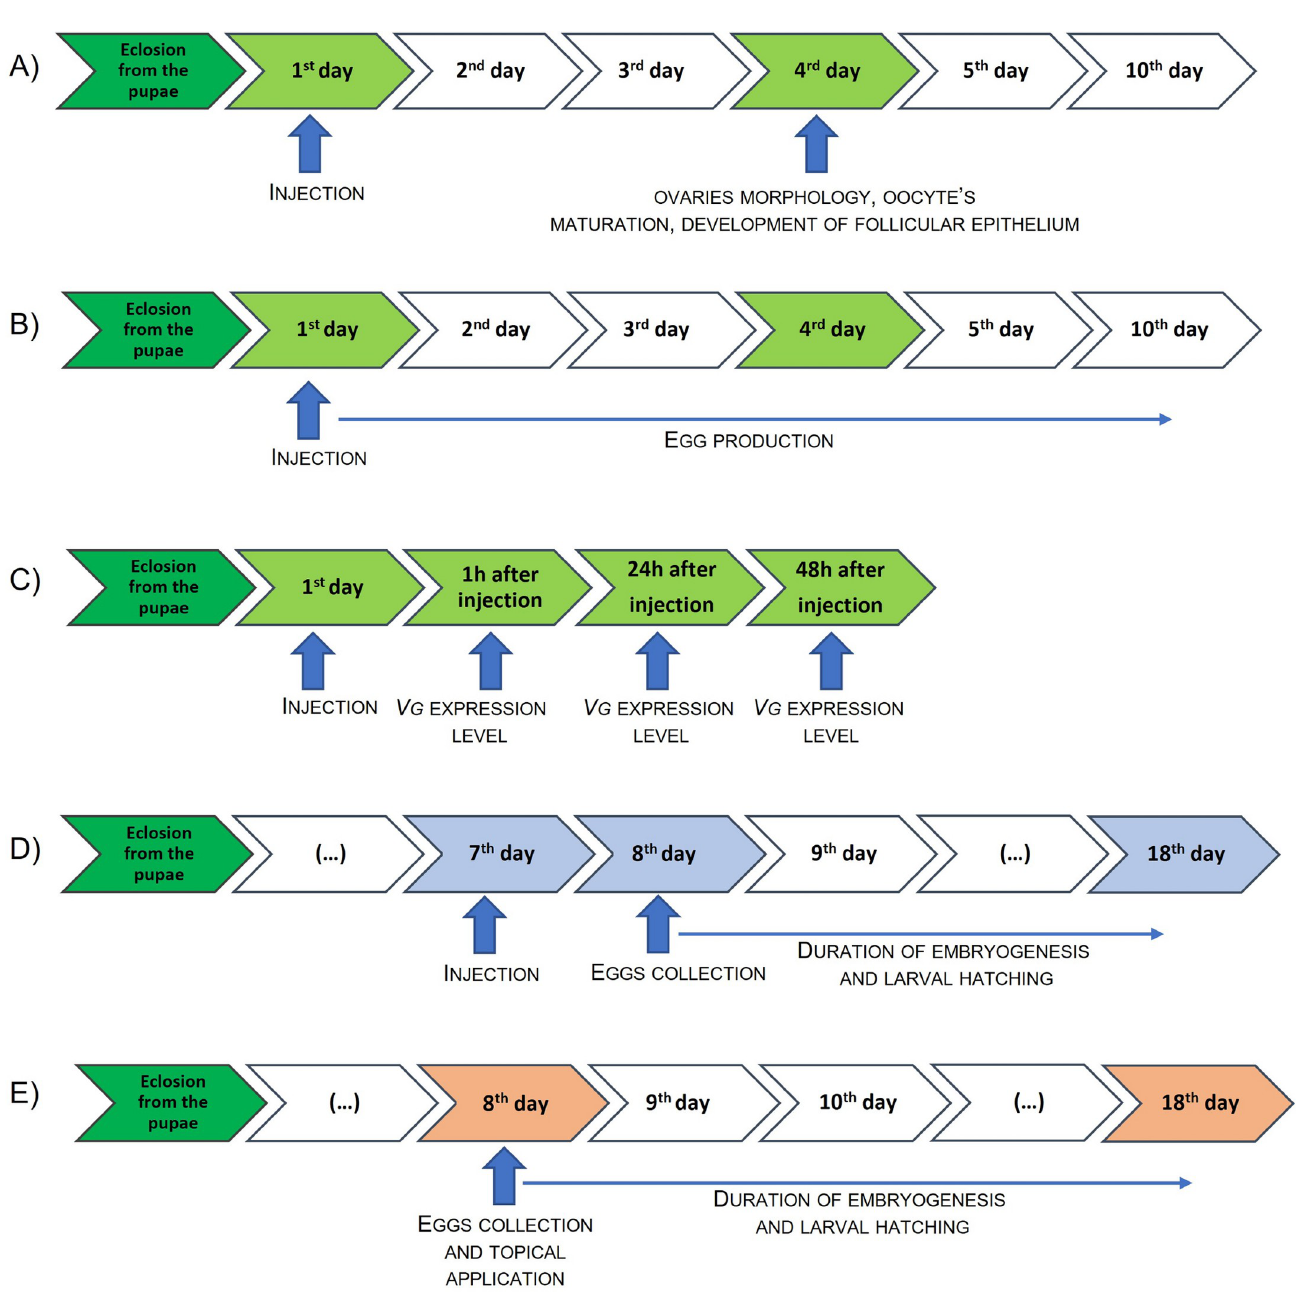
Fig 1. Timeline of experiments. A—Gonadotropic effects of peptides in females during the first reproduction cycle, the influence of peptides on the oocyte’s maturation process and development of follicular epithelium development, B—Influence of peptides on egg production, C—Examination of gene encoding vitellogenin expression level, D—Duration of embryogenesis and larval hatching after peptideinjection, E—Duration of embryogenesis and larval hatching after topical application of peptides.